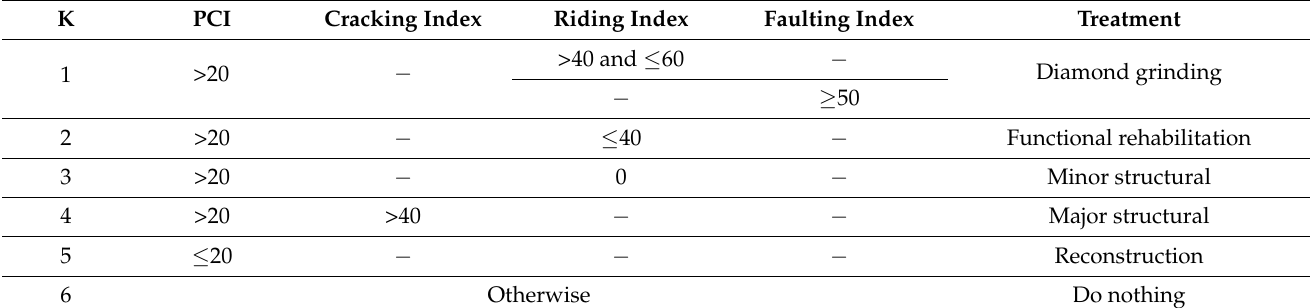
Table 4. Modified Iowa DOT decision matrix for PCC pavements.